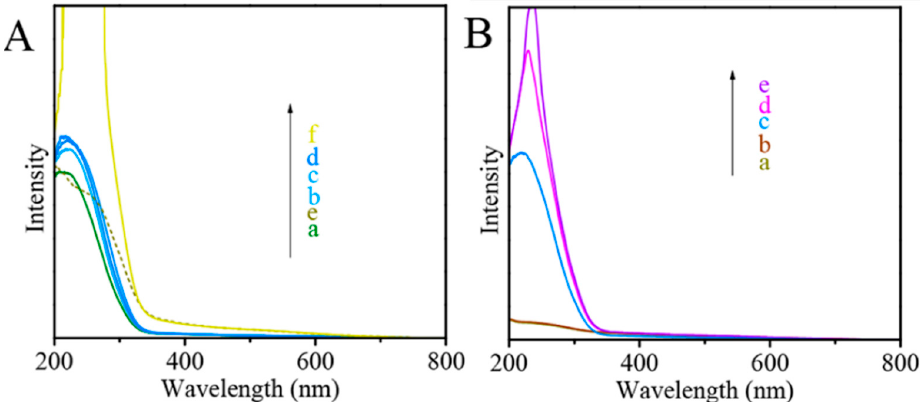
Figure 3. ( A ) UV-vis spectra of TiCl 3 aqueous solution (10 mg/mL) under different treatments: ( a ) Fresh, ( b ) 40, ( c ) 80, and ( d ) 200 μ L of NaHCO 3 aqueous solution (4 mg/mL) was added, and ( e ) 750 μ L of NaHCO 3 aqueous solution and 0.2 mL of Au nanoparticle colloid were added into ( a ), ( f ) 0.2 mL of Au nanoparticle colloid was added into ( d ); ( B ) UV-visible spectra of various liquors ( a and b ) Au nanoparticle colloid with Au concentration at ( a ) 0.68 and ( b ) 6.8 mg / L, ( c – e ) 40 µ L of TiCl 3 aqueous solution (0.37 mg / mL) was added into ( c ) H 2 O, ( d ) colloid a and ( e ) colloid b. Reprinted with permission